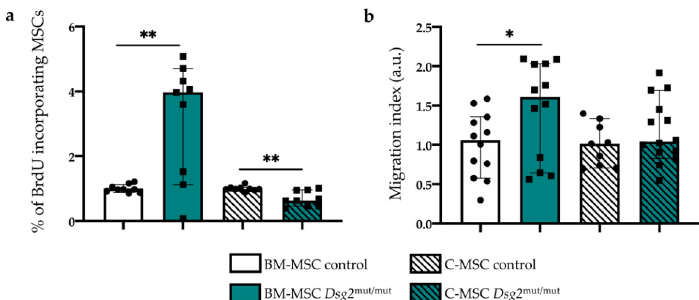
Figure 6. AC-linked Dsg2 variant enhances proliferation rate and migratory capacity of bone marrow mesenchymal stromal cells in vitro. ( a ) In vitro BrdU incorporation assay in control and Dsg2 mut/mut cardiac- and BM-MSCs. The fraction of BrdU incorporating MSCs was quantitated. At least 15.000 events per sample were acquired. Three independent experiments were performed. Bars represent mean, and error bars represent standard deviation (SD). ** p ≤ 0.01. ( b ) Transwell migration assay in cultured control and Dsg2 mut/mut cardiac- and BM-MSCs. Two independent experiments were performed. Bars represent median, and error bars represent the limits of 95% confidence interval (CI). * p ≤ 0.05.